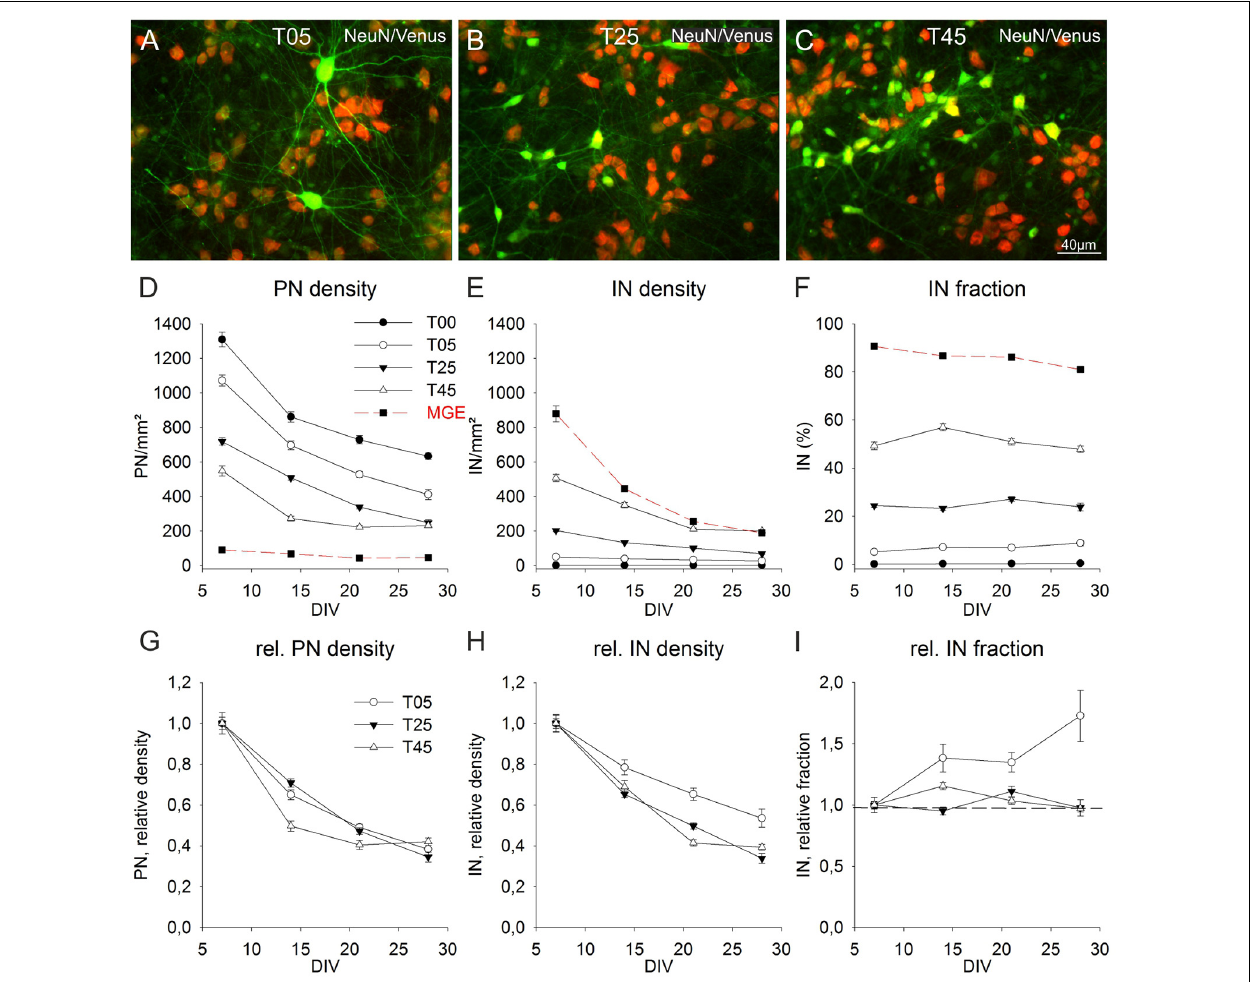
FIGURE 5 | Long-term population dynamics in different network types. Panels (A–C) show the color combined images of the Venus (green) and NeuN (red) staining in exemplary fields of 14-day-old T05 (A) , T25 (B) , and T45 (C) dCtx networks. The networks differ in their Venus neuron density. The quantitative analysis of the apparent soma size differences of Venus neurons between the different network types is shown in Figure 4 (J,K) . (D–F) Graphs show the development of PN (D) and IN (E) densities, and the fraction of INs (F) between 7 and 28 DIV. For better comparison, the data of T05, T25, and T45 networks were normalized to 7 DIV and are shown in (G–I) . The dotted line in graph (I) shows the normalized 7 DIV value for reference. For MGE networks in ( D , red dashed line) non-GABA neuron density is shown instead of the PN